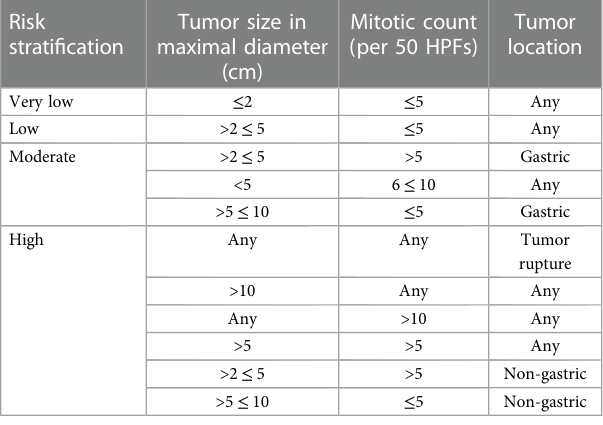
TABLE 2 Modi fi ed NIH criteria for risk evaluation of metastasis or recurrence or tumor-related death for patients with primary GISTs (18).